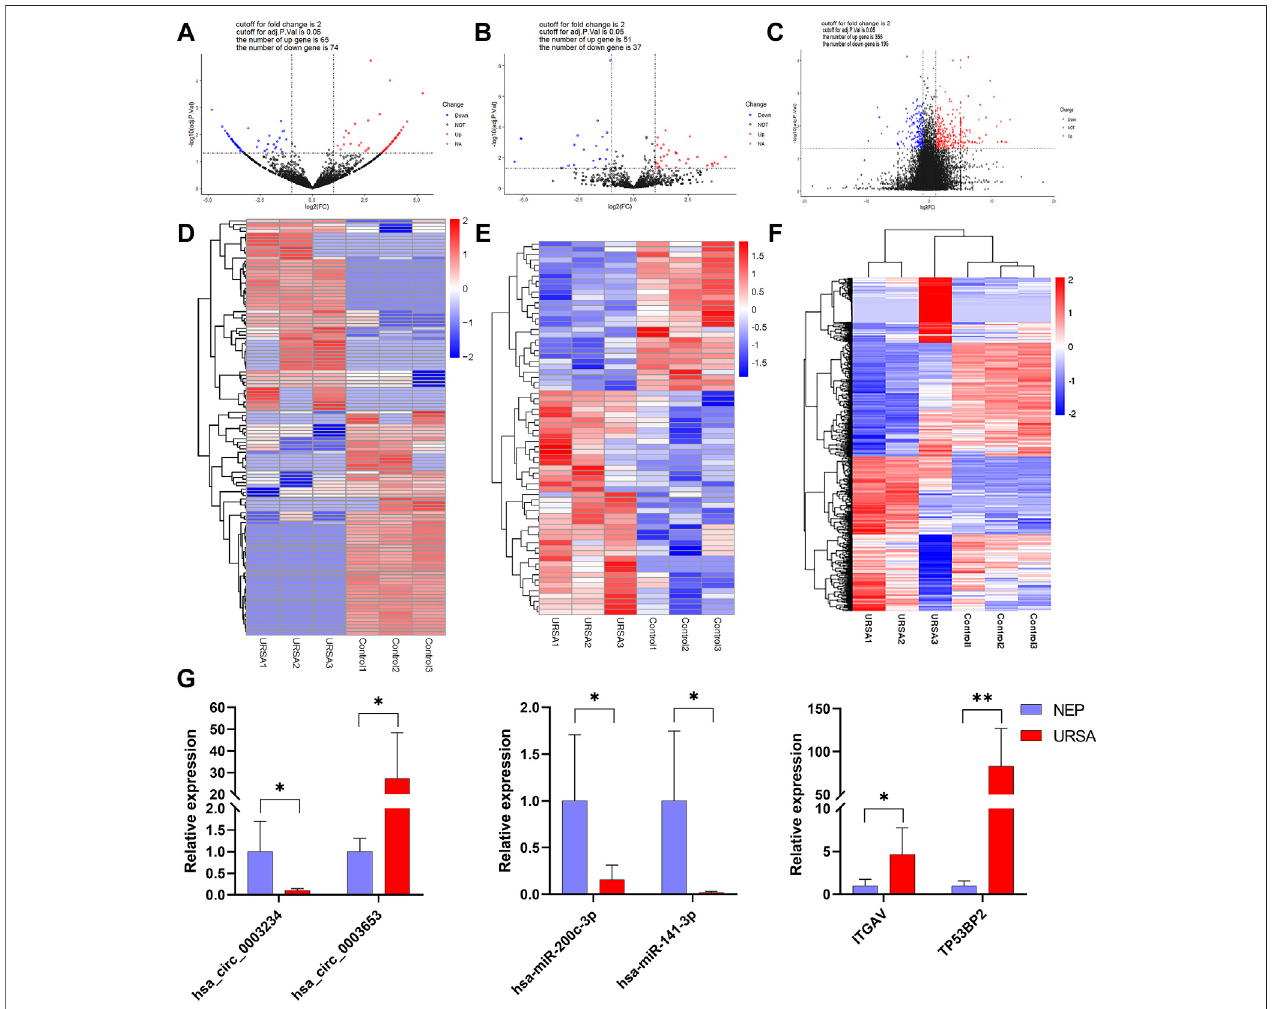
FIGURE 1 | The expression pro fi les of global circRNAs, miRNAs and mRNAs in decidua of URSA and NEP. (A – C) Volcano plots of differentially expressed circRNAs (A) , miRNAs (B) , and mRNAs (C) . Red dots indicate upregulated and blue dots indicate downregulated RNAs. Heat map of differentially expressed circRNAs (D) miRNAs (E) and mRNAs (F) generatedwithRNA-seq indecidua ofURSA patients and NEP. (G) The relative expression levels ofsixRNAs in URSA and NEP veri fi ed using RT-qPCR. URSA, unexplained recurrent spontaneous abortion; NEP, normal early pregnancy, * p < 0.05, ** p <